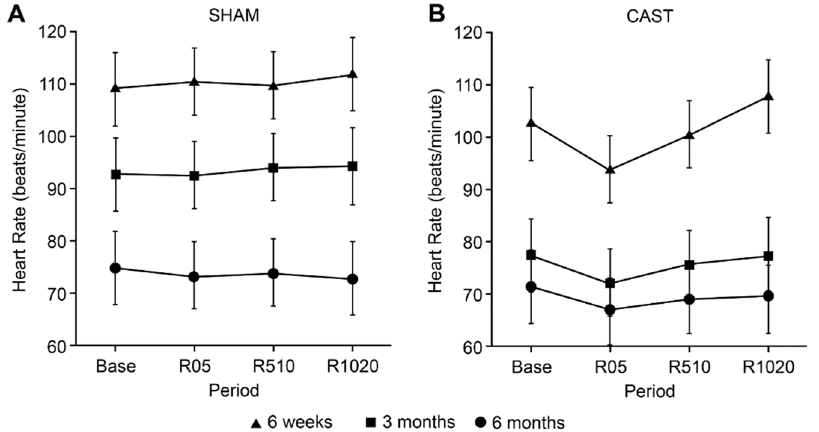
Figure 2. ( A ) Estimated least-square means and 95% confidence intervals of high-frequency power (HF; Hz) for 6-week (6W), 3-month (3M) and 6-month (6M) old calves undergoing CAST (square) and SHAM (triangle) ( B ) Time points evaluated consist of baseline (5 min before treatment; Base), early recovery (0–5 min after treatment; R05), middle recovery (5–10 min after treatment; R510), and late recovery (10–20 min after treatment; R1020).For LFP, there was no evidence for any differences between age groups or treatments over time. For LFP/HFP, evidence for a main effect of age was noted ( p = 0.0059), whereby 6M old calves (estimated least square mean, [95% confidence interval]: 5.35 n.u., [2.75, 10.43]) showed greater LFP/HFP than younger calves (6W: 0.74 n.u., [0.41, 1.33], p = 0.0058; 3M: 1.22 n.u., [0.89, 1.67], p = 0.0044) regardless of SHAM or CAST. 3.3. Infrared Thermography For average eye temperature (AET), a 2-way interaction was apparent between treat- ment and time ( p = 0.029), whereby differences in AET were identified between SHAM and CAST both before treatment (PRE; SHAM: 34.87 ± 0.26 °C; CAST: 35.41 ± 0.26 °C; p = 0.0179) and immediately after treatment (POST; SHAM: 34.47 ± 0.27 °C; CAST: 35.26 ± 0.26 °C; p = 0.001), though the POST difference was of greater magnitude. In addition, age dif- ferences were also noted on AET ( p = 0.0018), whereby 6M calves (36.1 ± 0.4 °C) had greater AET than 6W calves (33.8 ± 0.4 °C; p = 0.0013) regardless of treatment and time; 3M calves had an intermediate AET (35.2 ± 0.4 °C) that was not significantly different from the other age groups. Regarding minimum eye temperature, there was a marginally significant effect of treatment ( p = 0.0523), such that, regardless of age, minimum eye temperature was greater during CAST (30.1 ± 0.5 °C) than during SHAM (29.1 ± 0.5 °C).